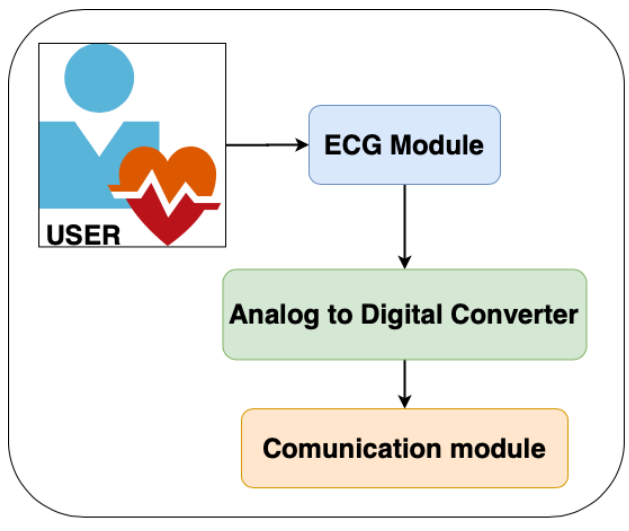
Figure 4. Architecture of Level